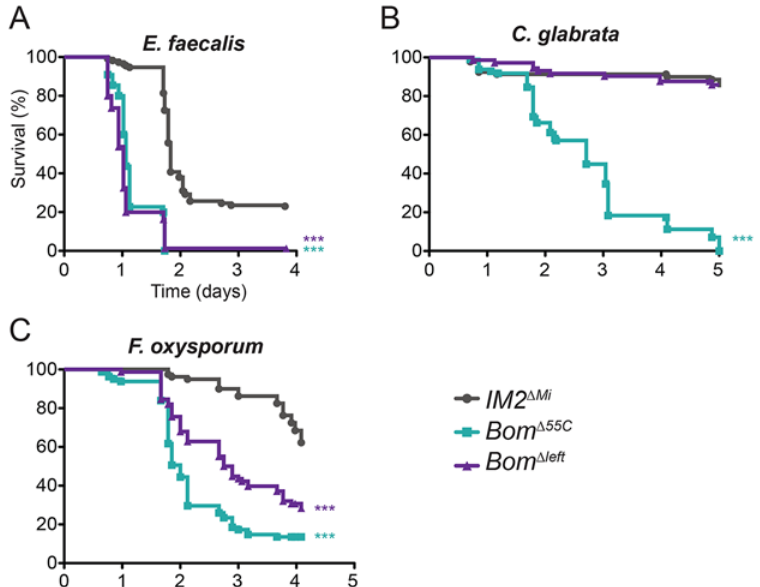
Fig 5. Loss of a subset of the 55C Bom genes has an intermediate effect on survival. Graphs indicate survival at indicated intervals post-infection with (A) E . faecalis , (B) C . glabrata , and (C) F . oxysporum . Each curve represents the pooled results of at least three independent experiments involving 20 or more flies per genotype. Survival curves were compared using the Gehan-Breslow-Wilcoxon test. Significance is relative to IM2 Δ Mi and adjusted for multiple comparisons ( *** p < 0.0003, n.s. = not significant, p >